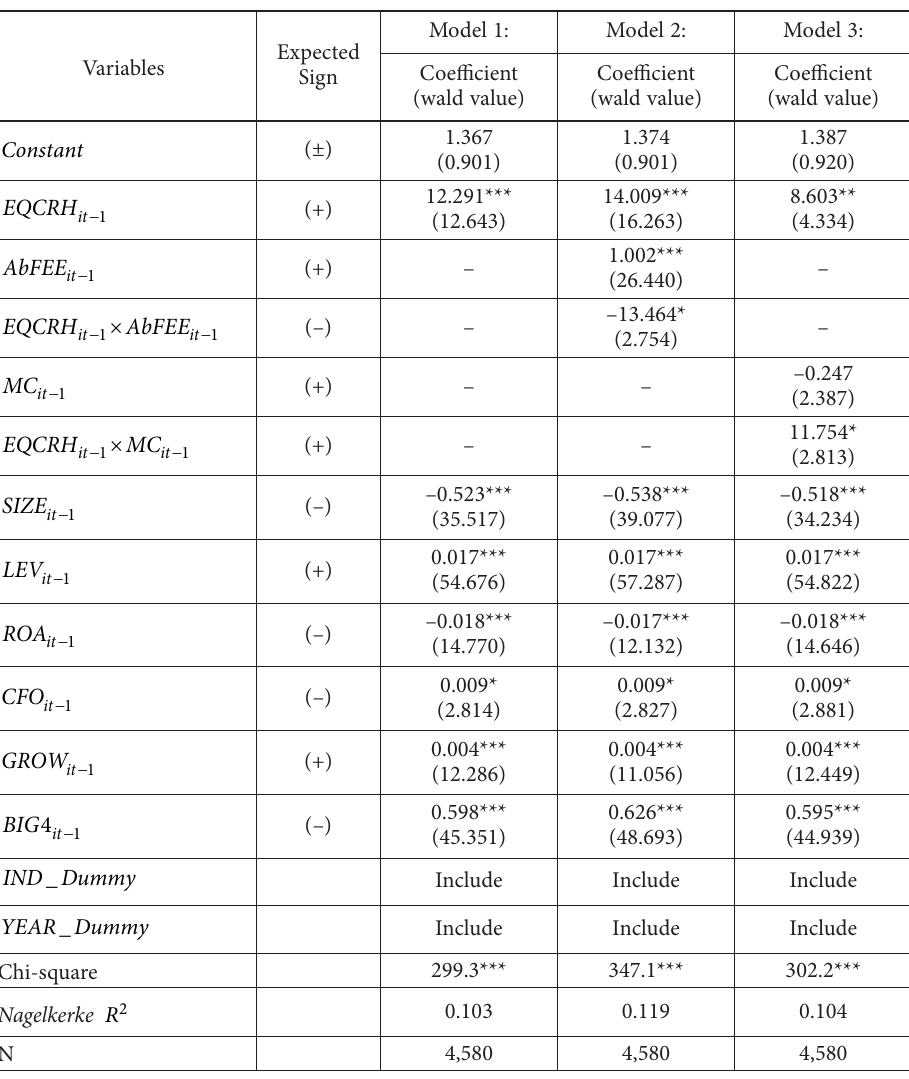
Table 4. Results for the effect of EQCR hours on auditor